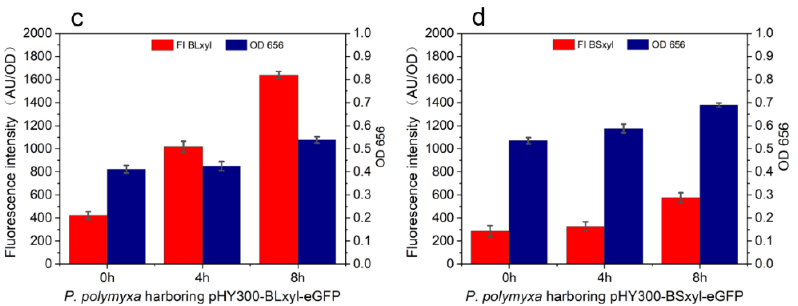
Figure 2. Fluorescence intensity levels of P. polymyxa harboring plasmids bearing xylose operons from different species. Construction of plasmids harboring eGFP and xylose operons from different species ( a ) . The OD 656 and fluorescence intensity levels of eGFP expressed by P. polymyxa ( b ), B. licheniformis ( c ), and B. subtilis ( d ) xylose-induced operon.